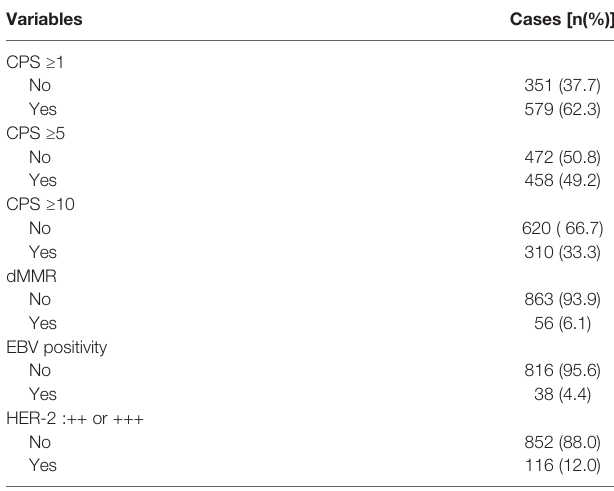
TABLE 2 | PD-L1 Expression (CPS), MMR and EBV Status and HER-2 Status in Gastric Cancer.